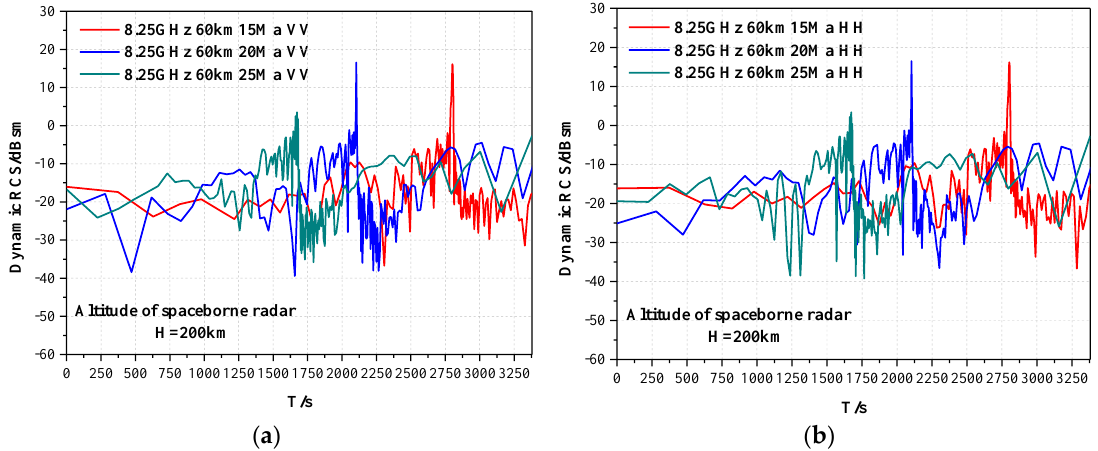
Figure 6. The DRCS time series of hypersonic target covered with plasma sheath at three di ff erent flying speeds. The flying altitude and incident EM wave frequency are taken to be 60 km and 8.25 GHz, respectively. ( a ) VV polarizations; and ( b ) HH polarizations.